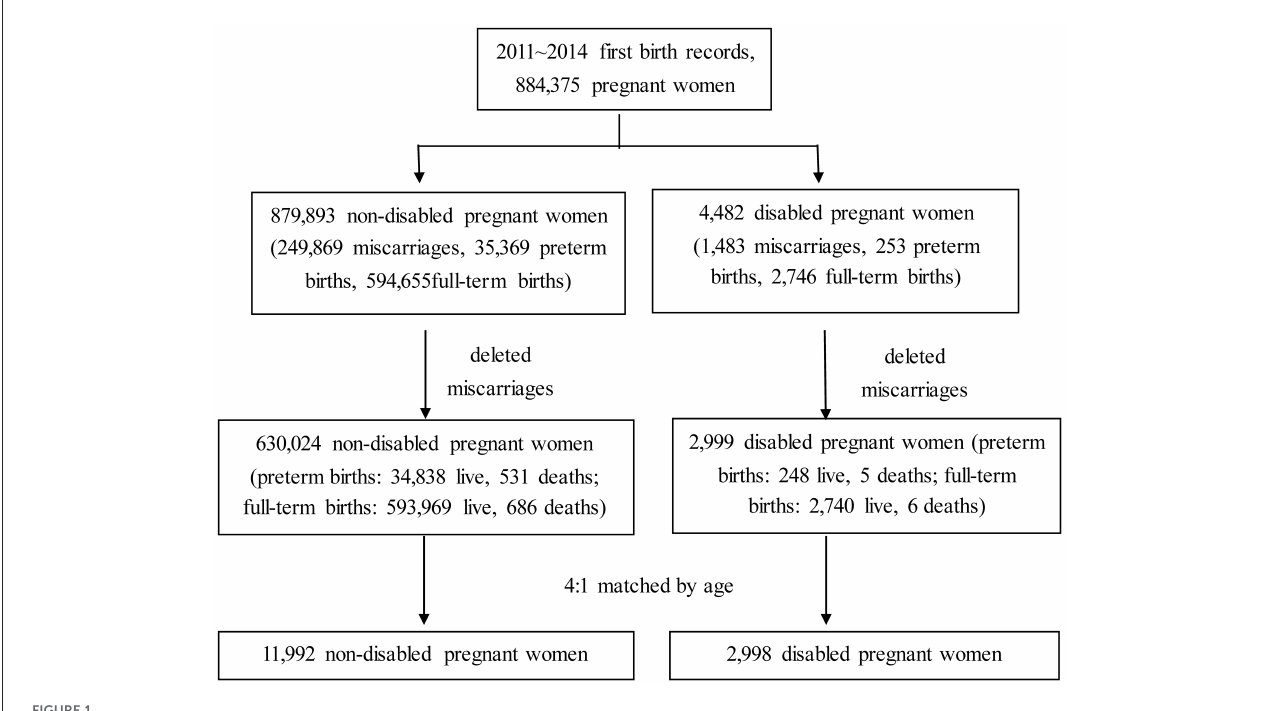
FIGURE1 The sample collection